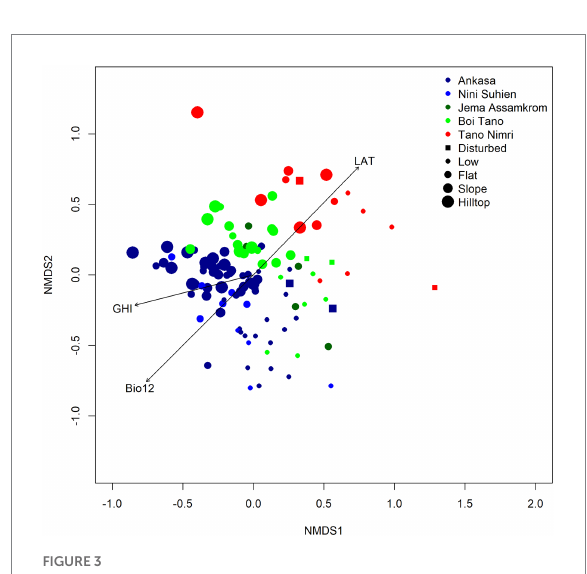
FIGURE 3 NMDS ordination of 114 samples of SW Ghana. Samples are coloured by reserve and sized by landscape position. Disturbed samples shown as squares. Significant environmental vectors are fitted (LAT = Latitude, Bio12 = annual mean